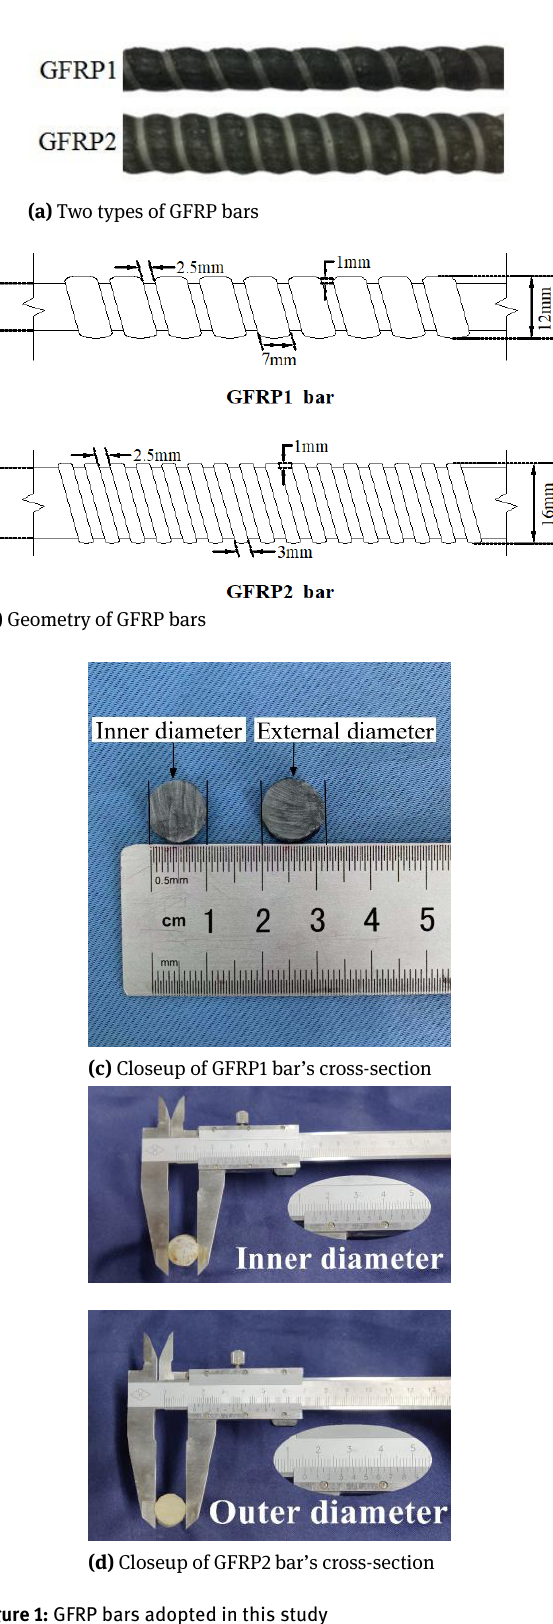
Figure 1: GFRP bars adopted in this study